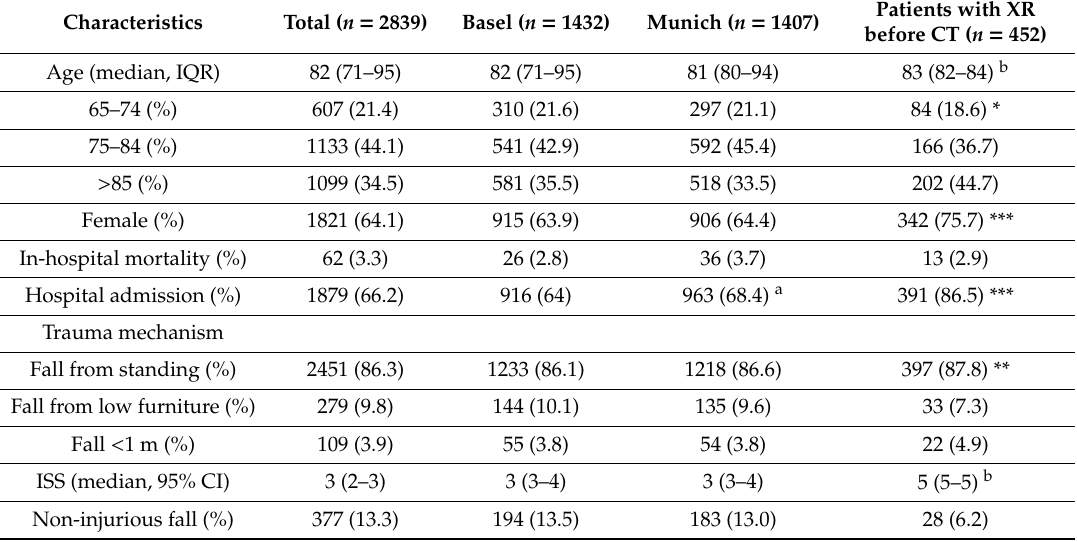
Figure 1. Inclusion and exclusion flow diagram of patient selection from 1 January 2016 to 31 December 2016 in Basel and Munich, receiving computed tomography (CT) examination of the head, spine, chest, pelvic ring or proximal long bones during emergency department (ED) presentation or within 48 h. GP = general practitioner, XR = plain radiography. Table 1. Baseline characteristics of 2839 older adult patients presenting with low-energy falls from 1 January 2016 to 31 December 2016 and characteristics of patients ( n = 452) that received “XR before CT imaging”.